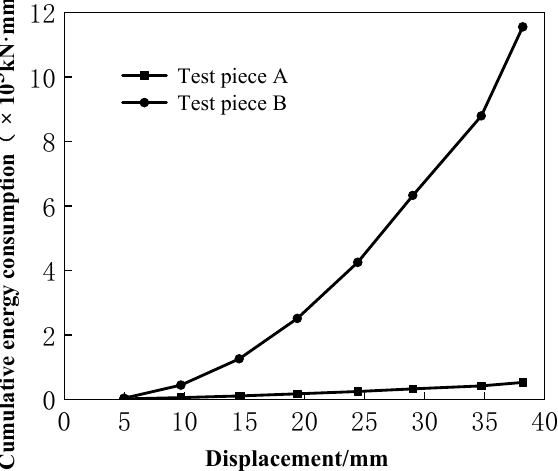
Figure 11. Cumulative energy dissipation curve of different types of piers.